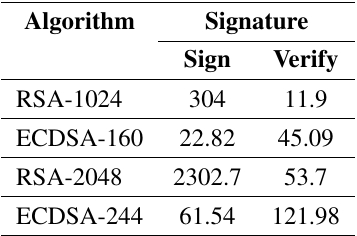
Table 3. The energy cost of cryptographic primitives